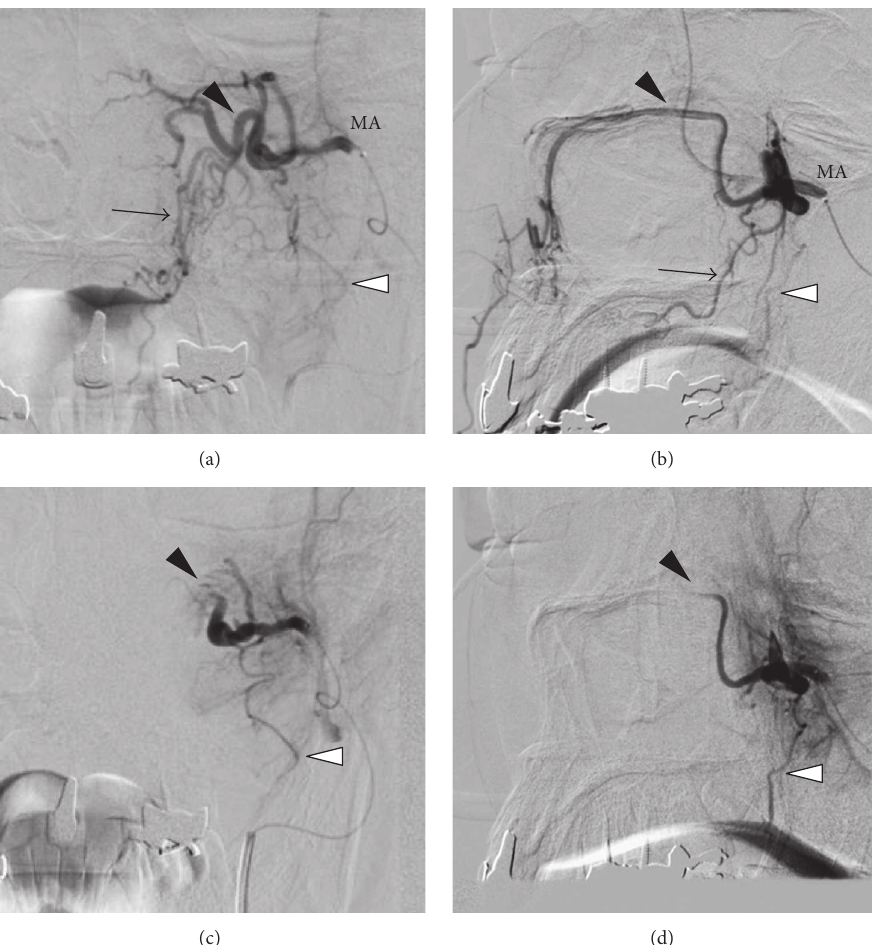
Figure 2: Digital subtraction angiography of the left maxillary artery (MA) in AP view (a, c) and lateral view (b, d). (a, b) Before embolization, well-developed sphenopalatine artery (SPA, black arrowhead) and descending palatine artery (DPA, arrow) were detected. (c, d) After embolization, the SPA and DPA disappeared, while the posterior superior alveolar artery (white arrowhead) was